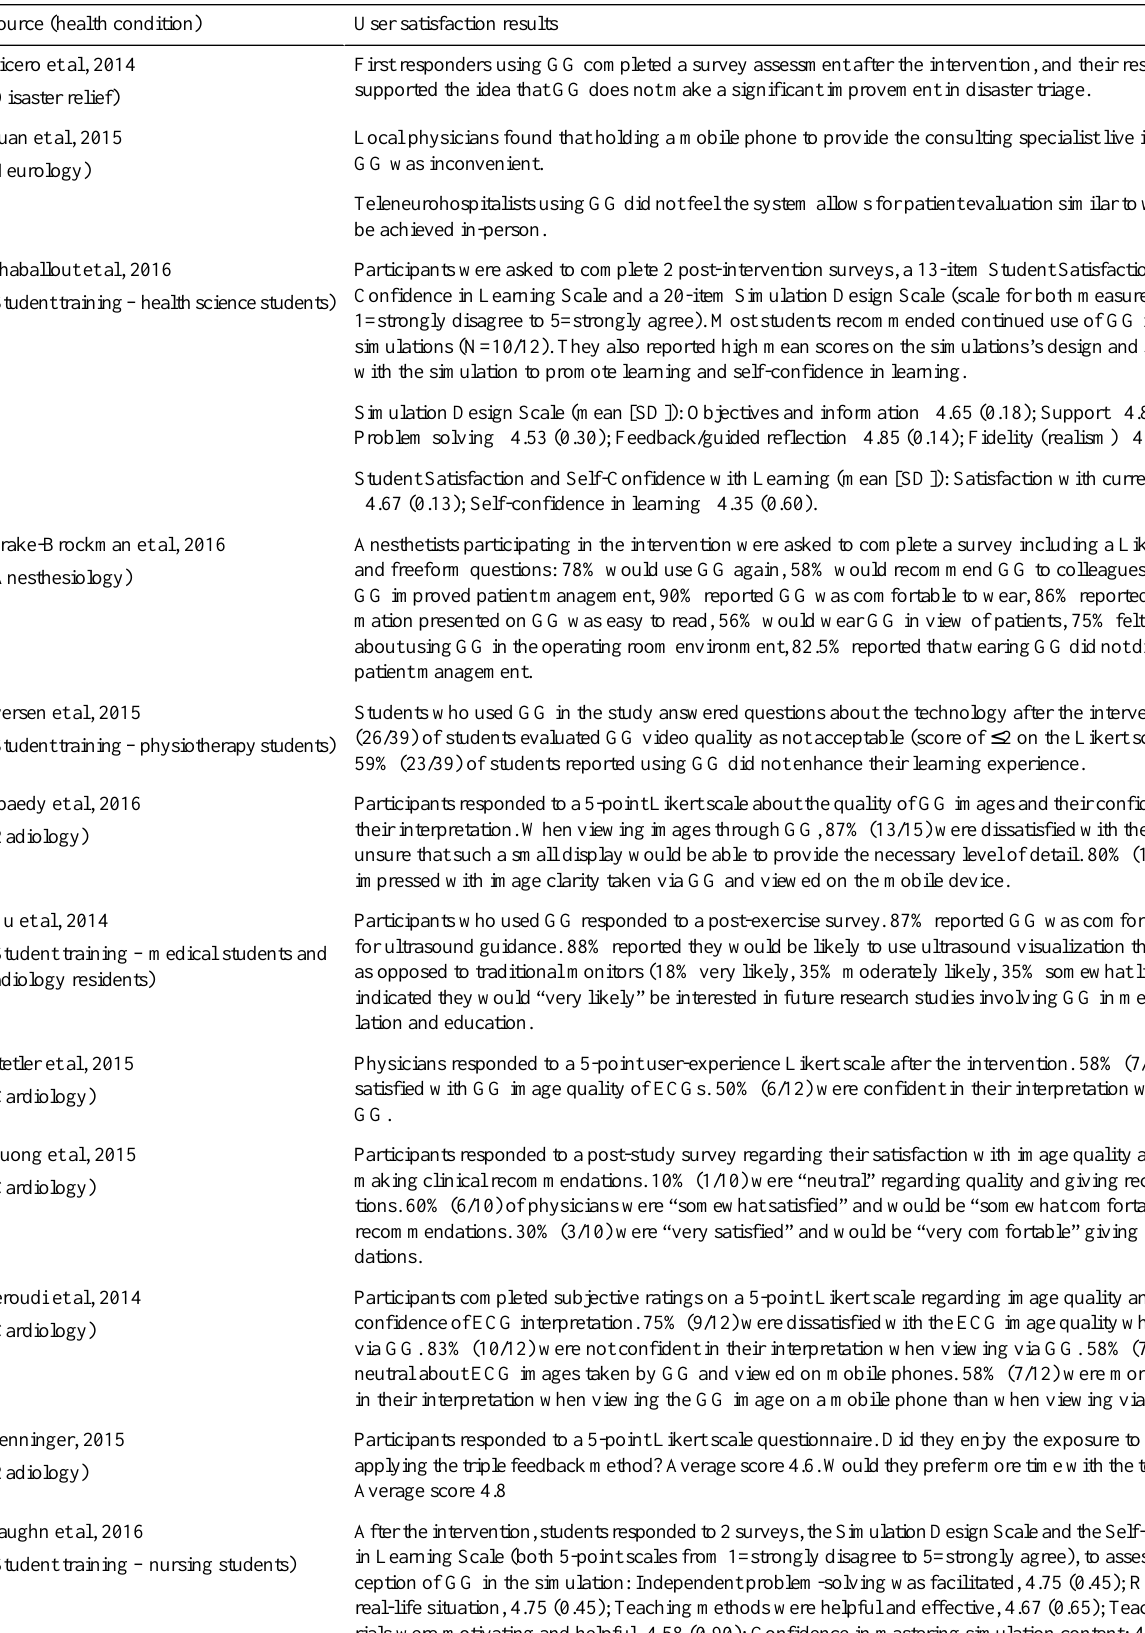
Table 6. Feasibility and acceptability of Google Glass as clinician-centered interventions.